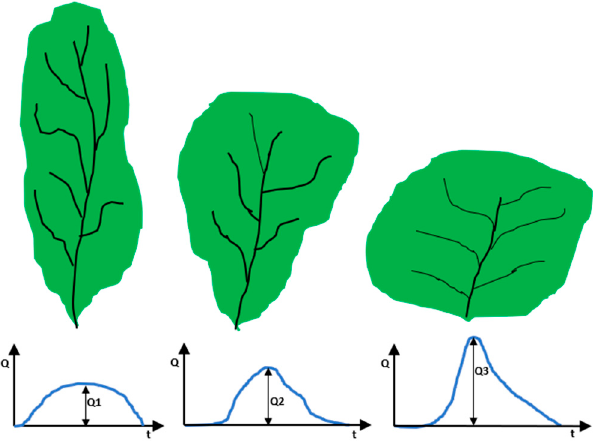
Figure 1. Influence of the geometry of basins and associated flood hydrographs of peak flow (Q).